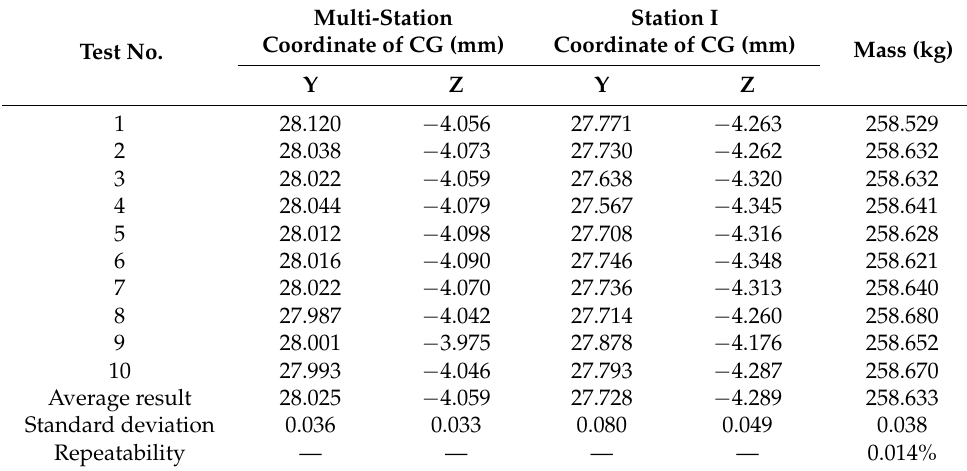
Table 2. Measurement results of mass and